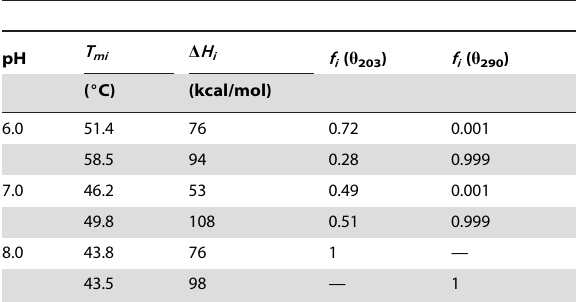
Table 1. Dependence on pH of CM-Cpl-7 thermal denaturation